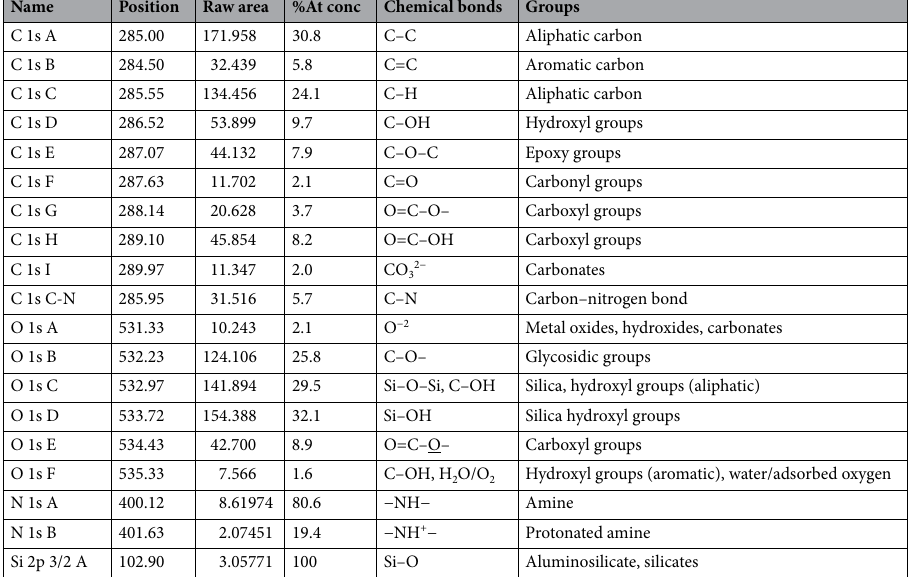
Table 5. Elemental composition of sample 3 (from Lower Foxfonna Glacier, elevation, 609 m) with the identification of characteristic chemical bonds 35–38 determined by